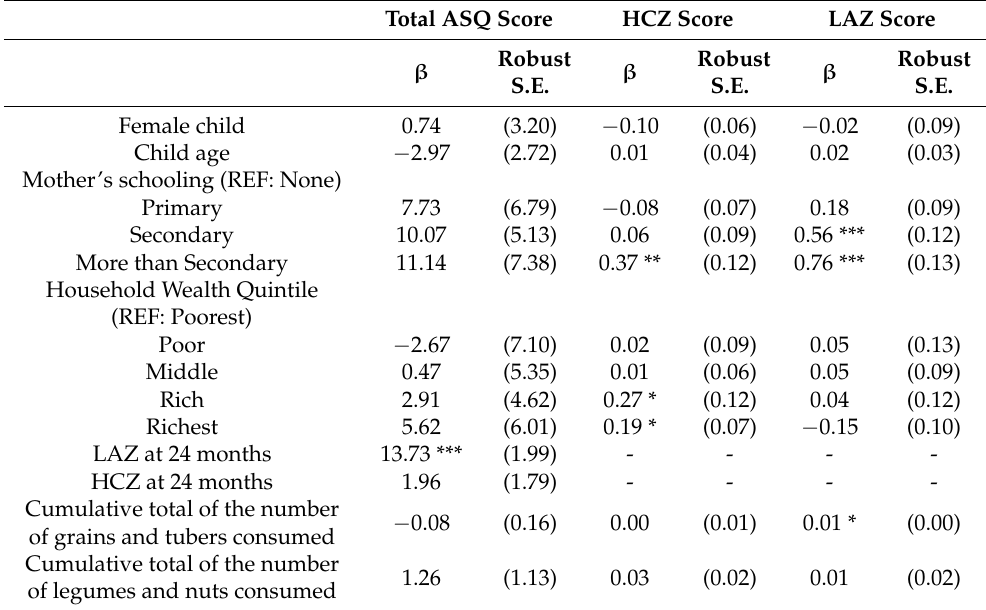
Table A4. Association between ASQ score, HCZ and LAZ, and the cumulative total of the number of food groups